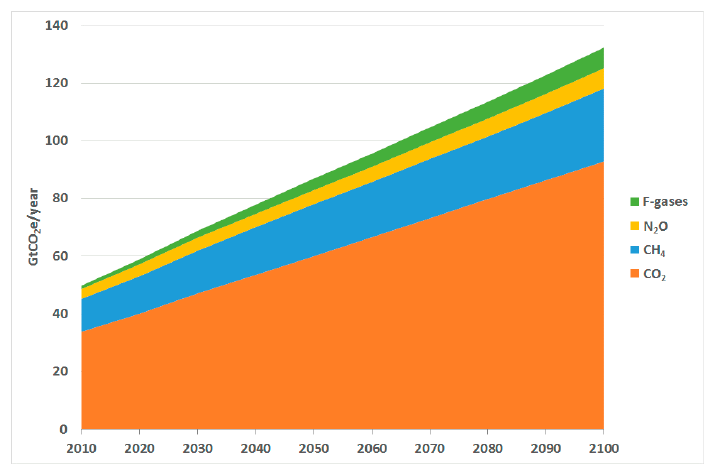
Figure 1. Global greenhouse gas emissions in the (unmitigated) reference scenario. Notes: The approximately linear nature of these GHG emissions levels is primarily because of the approximately linear nature of the CO 2 emissions level, which is coincidental only. Emissions values follow from detailed modelling of the energy and non-CO 2 GHG emitting sectors in 10 year time-steps from the TIAM-Grantham and GAINS models used in this analysis. As shown in Appendix C which decomposes the CO 2 emissions levels, the CO 2 emissions pathway results from non-linearly increasing GDP, offset by non-linearly decreasing primary energy intensity of GDP, combined with approximately constant CO 2 intensity of primary energy.